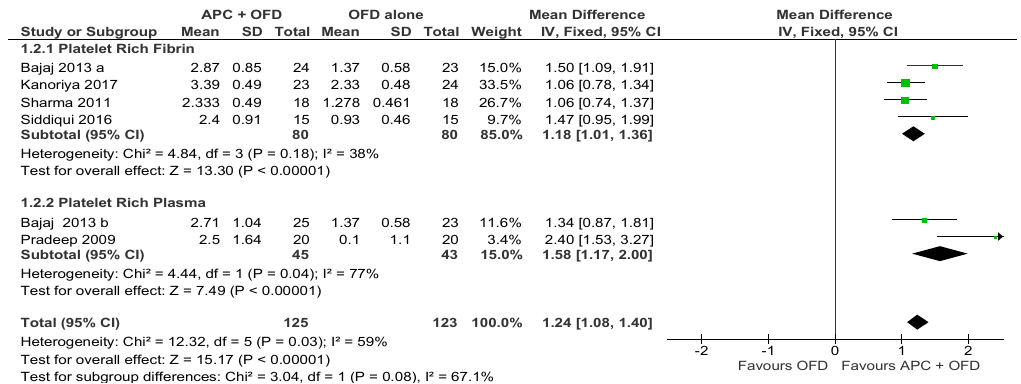
7 of 17 Figure 3. Forest plot showing the effect on probing pocket depth for comparison of APC + OFD versus OFD alone at end of all-follow-up (6–12 m). APC + BG vs. BG Alone (Figure 4) The forest plot of the included studies evaluating the change in PPD in using APC in adjunct with BG favors the use of BG alone; however, the result is not statistically significant ( p = 0.26, mean difference −0.08, 95% CI −0.22, 0.06). Figure 4. Forest plot showing the effect on probing pocket depth for comparison of APC + BG versus BG alone at end of all-follow-up (6–12 m) . 2.2.2. Vertical Clinical Attachment Level (VCAL)